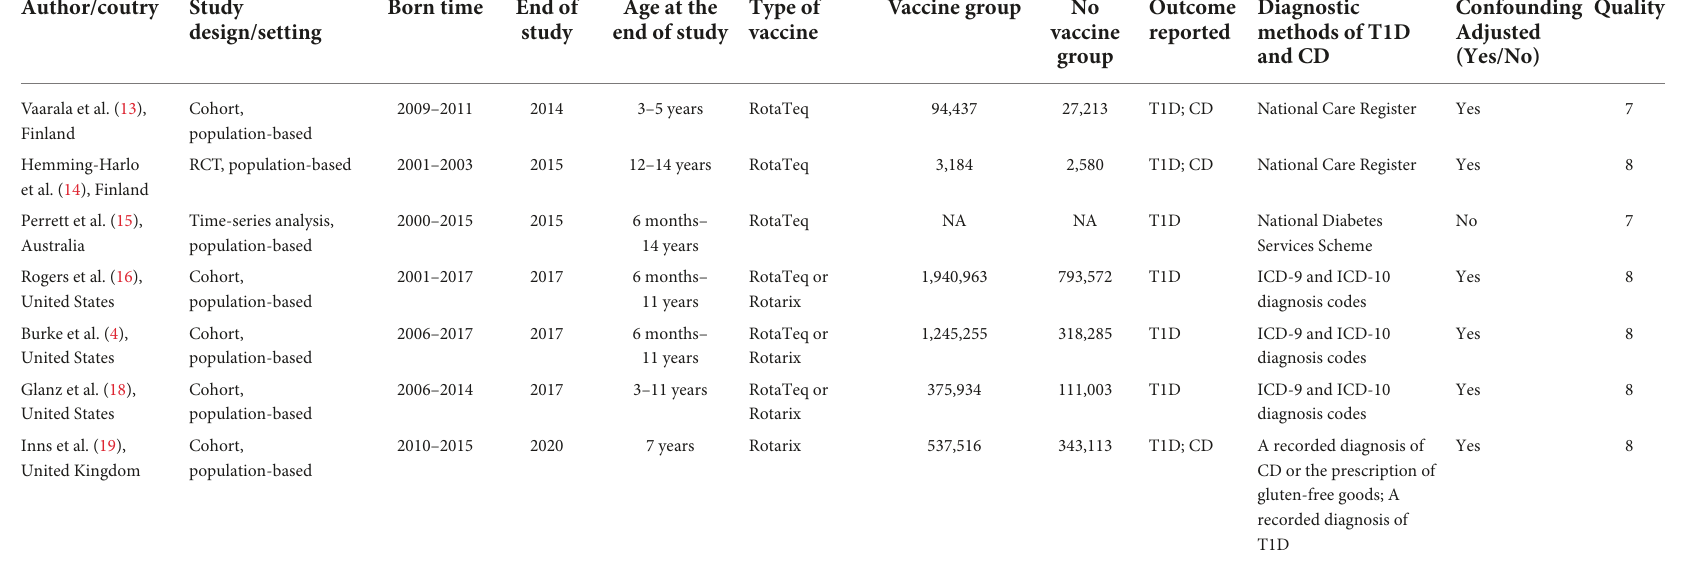
TABLE 1 Characteristics of the included